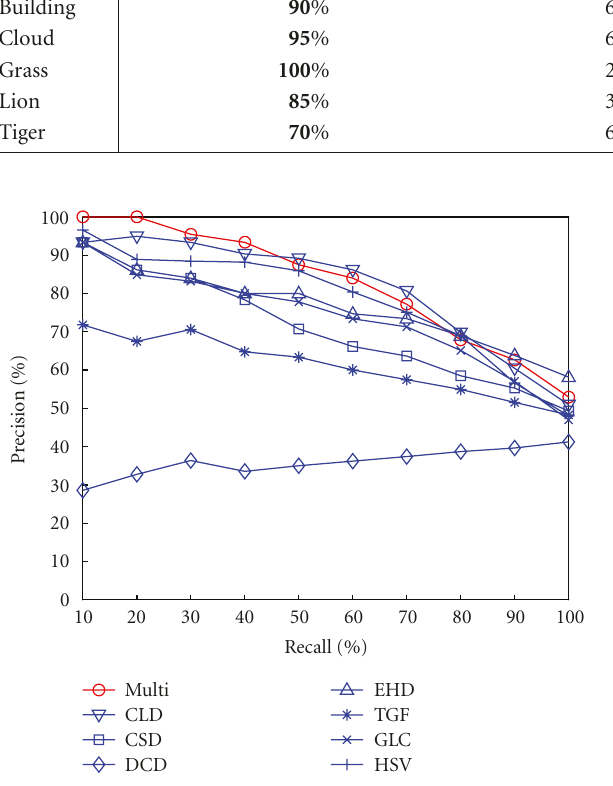
Figure 10: Precision-recall curves for concept grass using the mul- tifeature combination metric and using single descriptors.